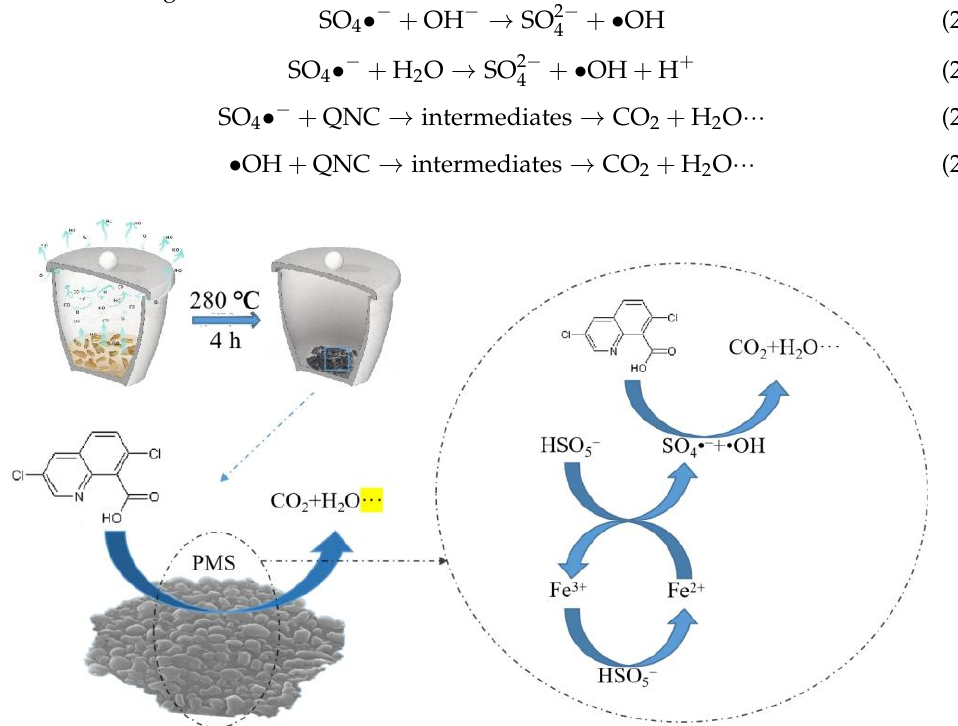
Figure 7. The possible degradation mechanisms of QNC in the E/Fe–N–BC/PMS system.